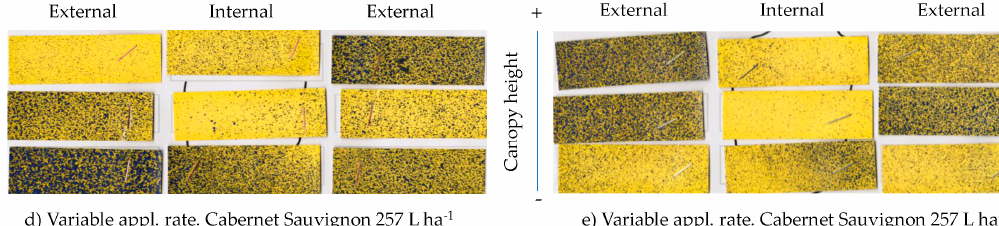
Figure 10. Coverage (WSP) obtained with conventional spray application (CONV) (a), in comparison with coverage obtained at the four selected varieties when using variable rate application (VRA) (b, c, d and